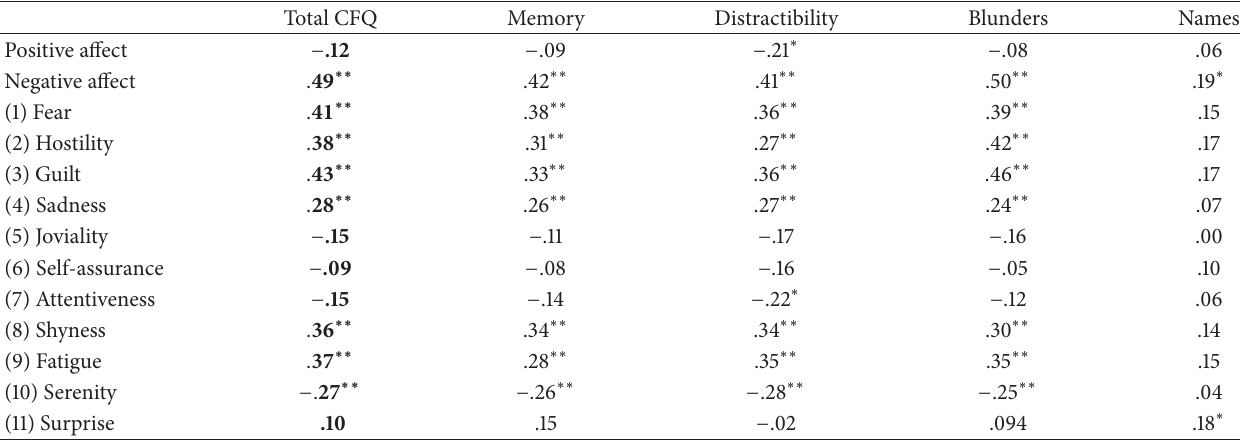
Table 5: Correlations between affect and cognitive